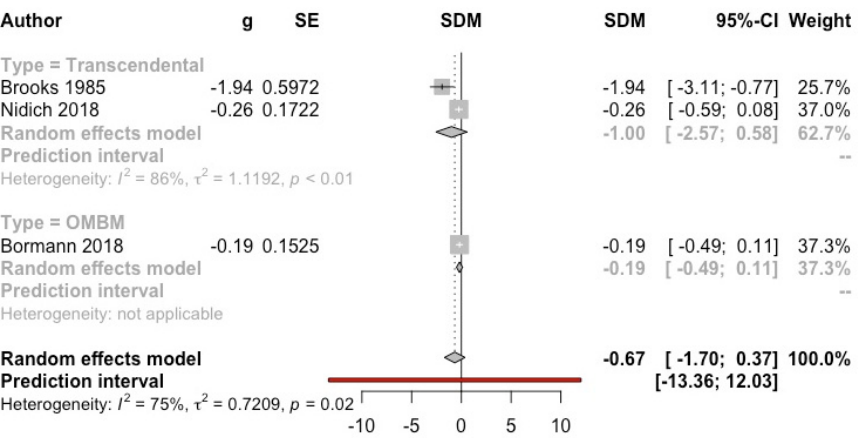
Figure 5. Effect on depression (meditation vs. psychotherapy). Predictive intervals are represented in red.